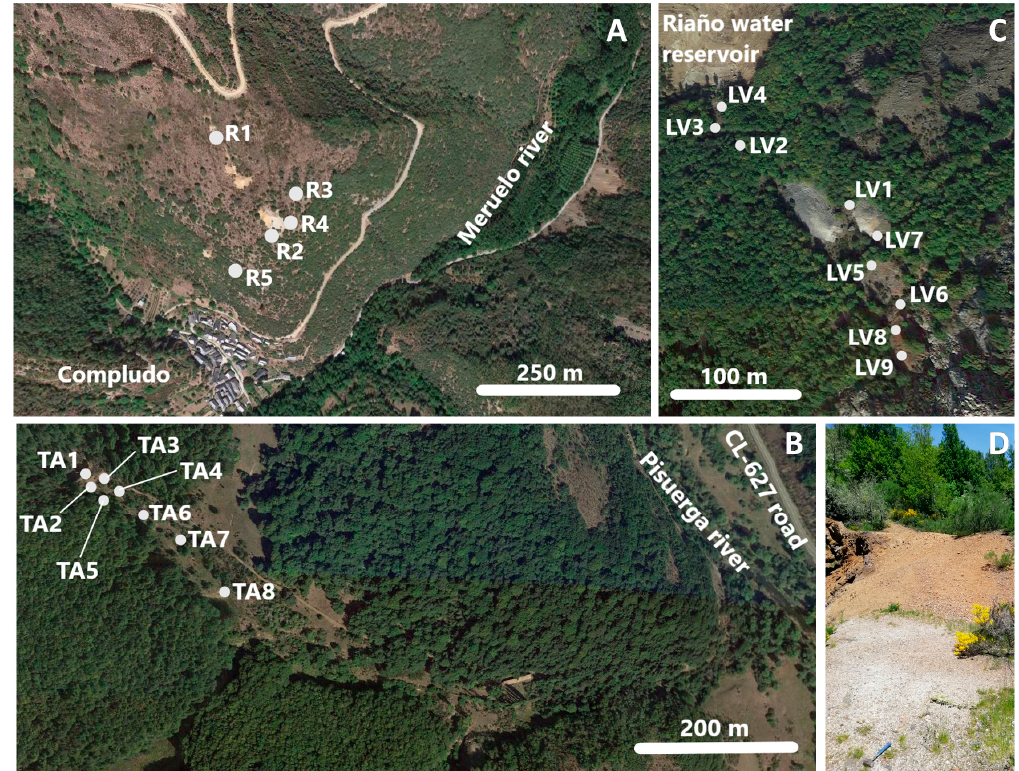
Figure 2. Location of sampling points. ( A ) Rita mine (samples R1 to R5); ( B ) Tres Amigos mine (samples TA1 to TA8); ( C ) Las Viescas mine (samples LV1 to LV9); ( D ) location of sampling point TA1 in a spoil heap at Tres Amigos mine (pointed by the hammer).